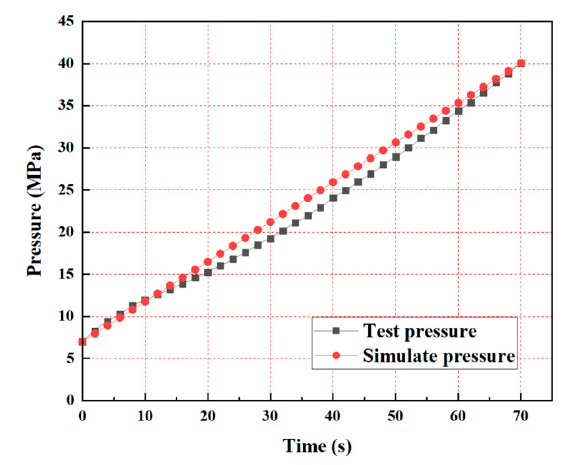
Energies 2023 , 16 , x FOR PEER REVIEW Figure 4. Inlet pressure curves from the experiments and numerical simulations.